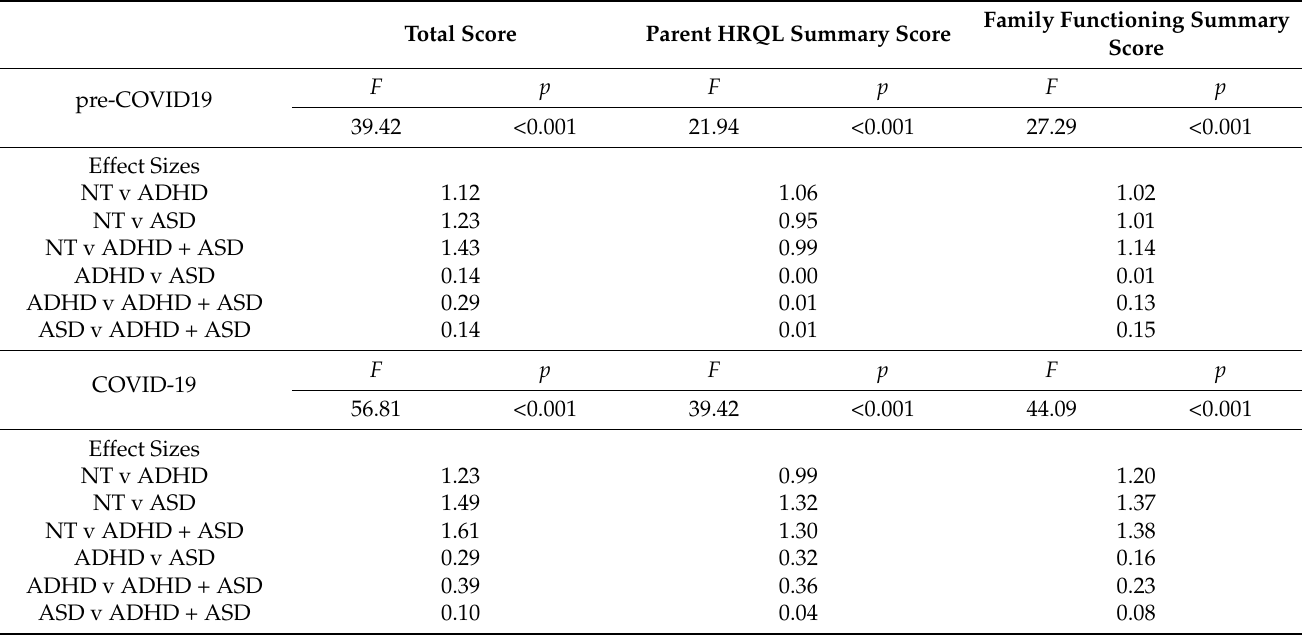
Table 3. Results from the one-way ANOVAs and effect size (Cohen’s d ) calculations.